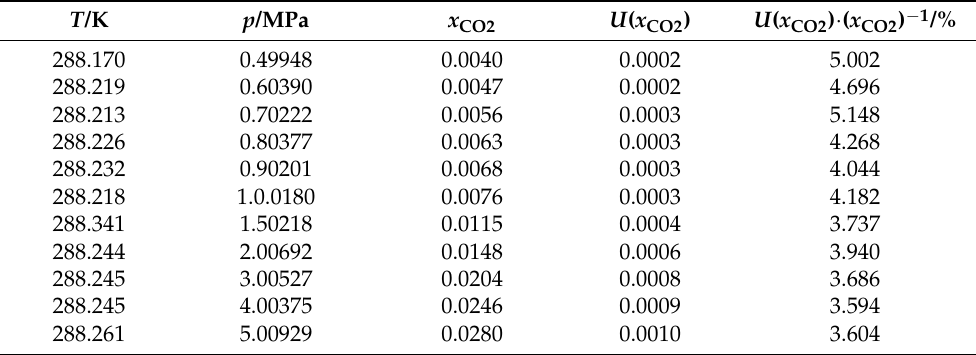
Table A1. Experimental results for solubility measurements of pure carbon dioxide in water at T = 288.15 K using Raman spectroscopy. Recorded temperature (ITS-90), pressure, mol fraction and estimated uncertainties ( k = 2) are listed in the table.